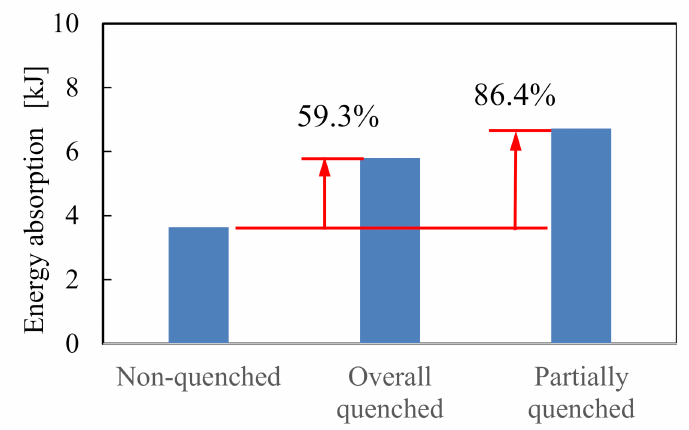
Figure 19. Energy absorption of product with optimized partially quenched area (see Figure